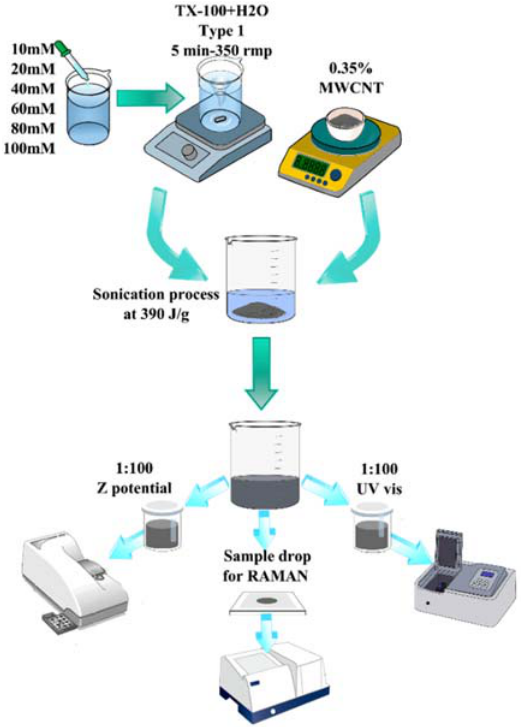
Figure 1. Scheme of the procedure to produce and analyze the dispersion of MWCNTs dissolved in type 1 water, varying the molarity of the surfactant between 10 mM and 100 mM.